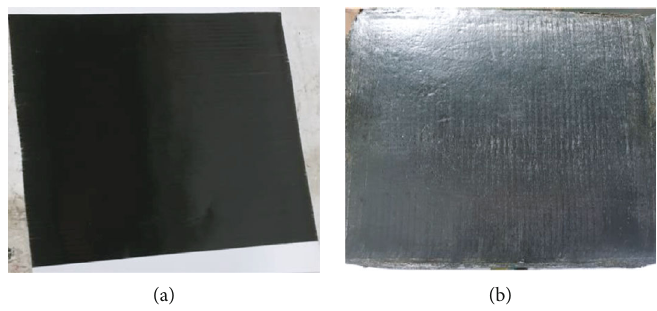
Figure 3: Composite UD samples: (a) single sheet of prepreg and (b) four-ply composite plate after curing.